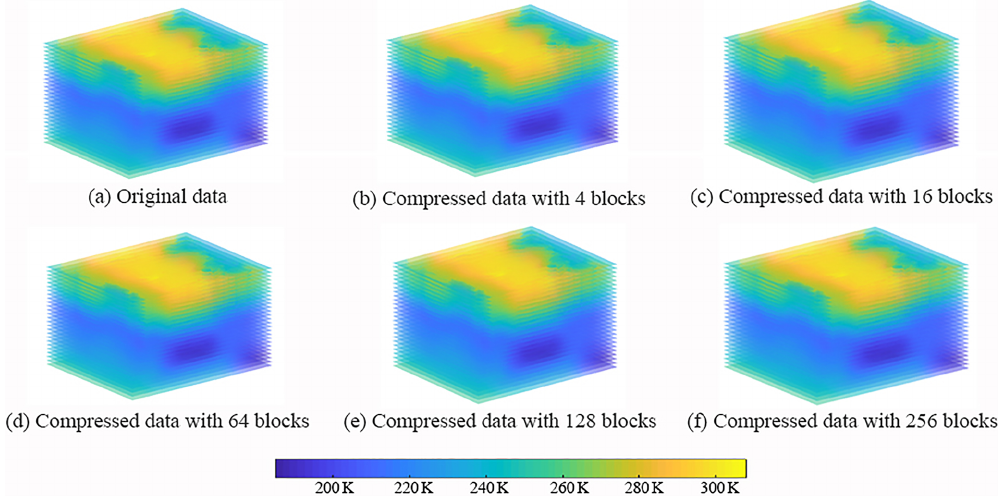
Figure 3. Original data and compressed data with different block counts: (a) the original data, (b) the compressed data when the data count is 4, (c) the compressed data when the data count is 16, (d) the compressed data when the data count is 64, (e) the compressed data when the data count is 128, and (f) the compressed data when the data count is 256.